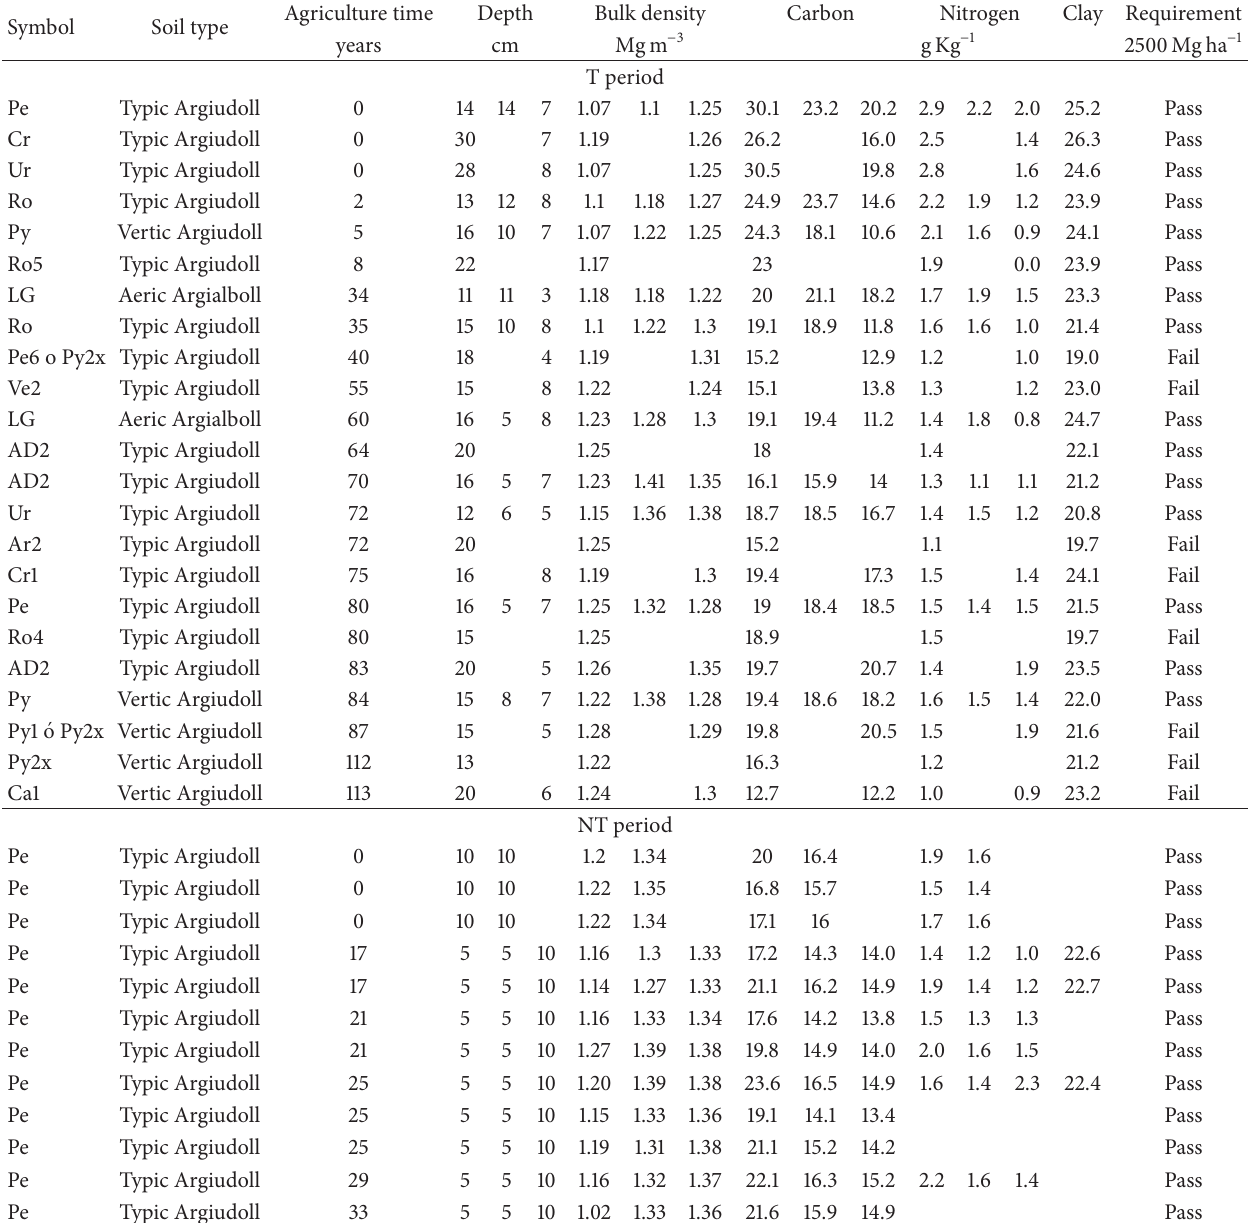
Table 5: Soil organic carbon and nitrogen contents (mgg − 1 ) and bulk density (Mgm − 3 ) of the different soil depths and A horizon clay content (mgg − 1 ) at 2500 Mg soil ha − 1 used in all the sites